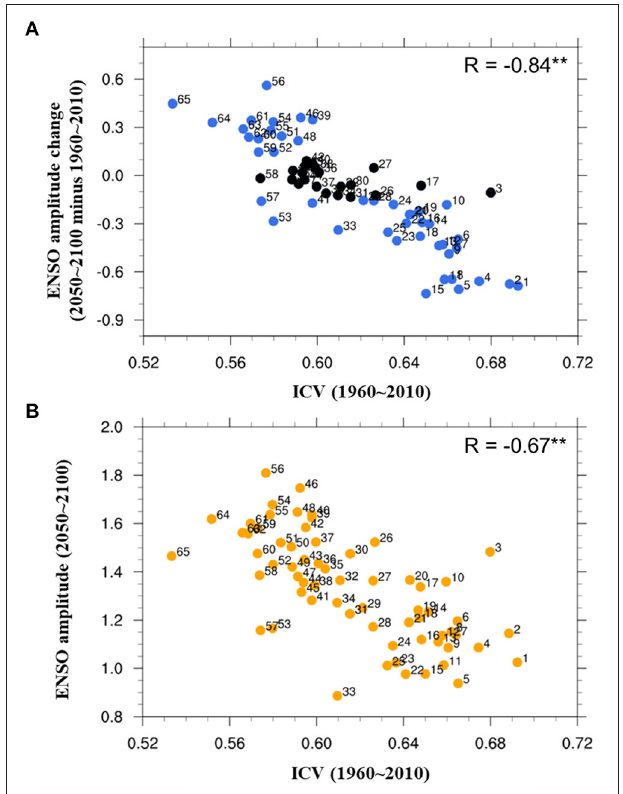
FIGURE 5 | ICV in the present climate vs. ENSO amplitude change from the present climate (1960–2010) to the future climate (2050–2100) (A) . (B) is the same as in (A) except the ENSO amplitude in the future climate. Note that numbers in figure denote the 65-ensemble members ranked by the intensity of ICV from the strongest to the weakest during the present climate (see Figure 2 ) and black circles in (A) indicates the ensemble member in which the ENSO amplitude changes stays the same from the present climate to the future climate. Unit is ◦